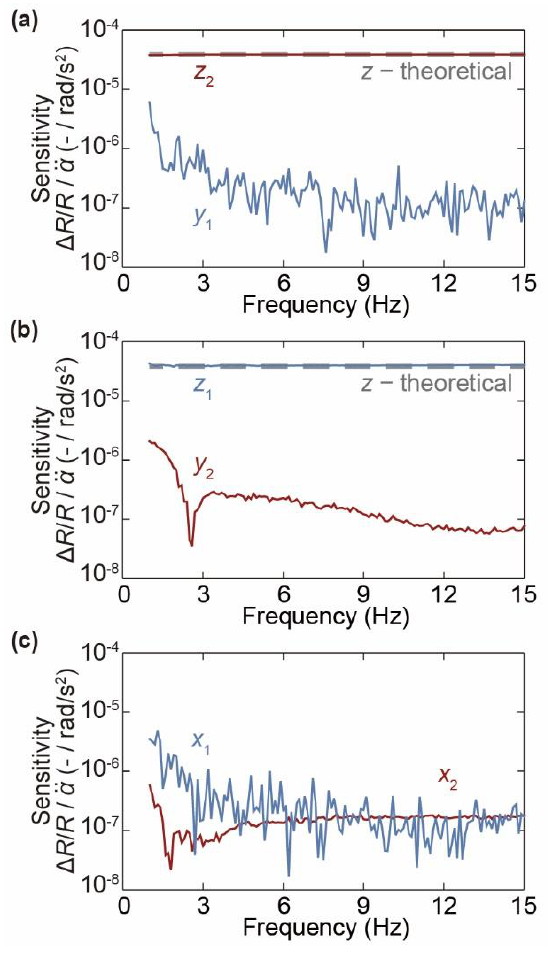
Figure 10. Relationship between the frequency of the applied angular acceleration and sensitivity for each axis of the sensor. ( a ) z -axis direction, ( b ) y -axis direction, and ( c ) x -axis direction.